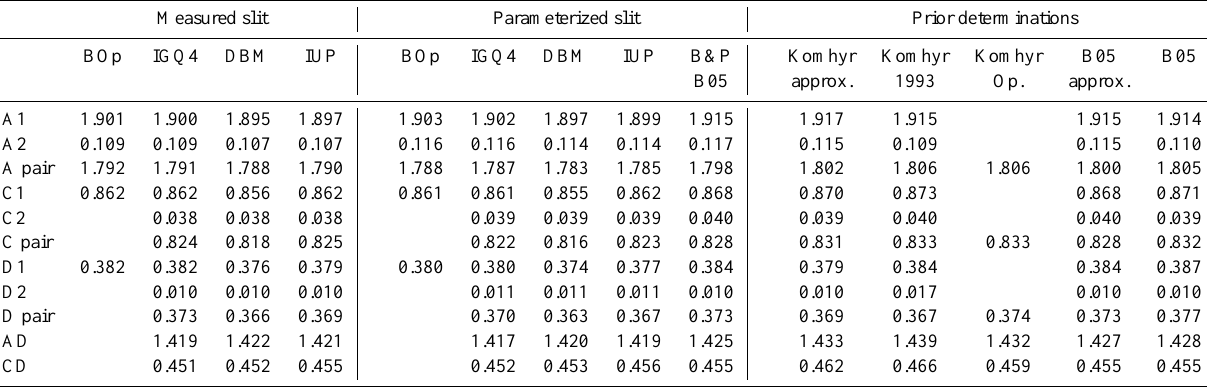
Table 2. Summary of Dobson ozone absorption coefficient in atmcm − 1 , determined from the five ozone cross sections (see text for details) using measured slit functions and parameterized slit functions. Values from Komhyr and Bernard are also displayed for comparison. The calculations using B&P cross sections by Bernhard et al. (2005) (B05) are also calculated for the parameterized slit functions.